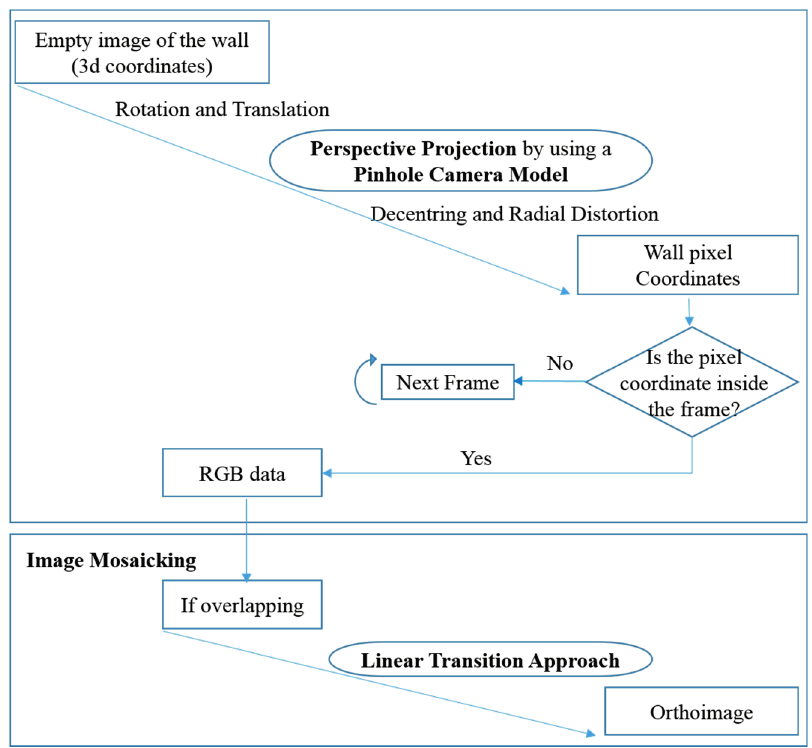
Figure 9. Schema of the procedure of orthoimages